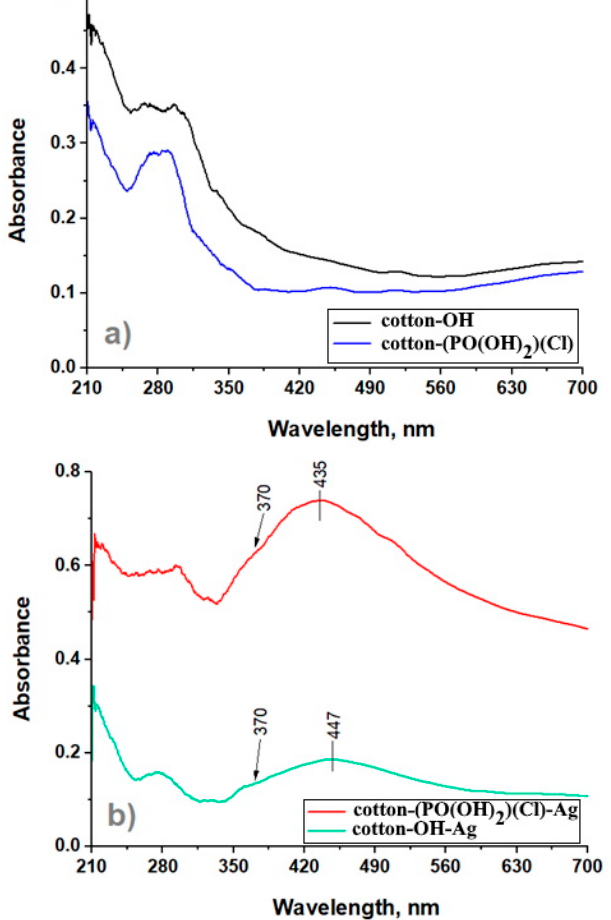
Figure 2. UV–visible spectra of samples: cotton-OH and cotton-(PO(OH) 2 )(Cl) ( a ) and cotton-OH-Ag and cotton-(PO(OH) 2 )(Cl)-Ag ( b ).